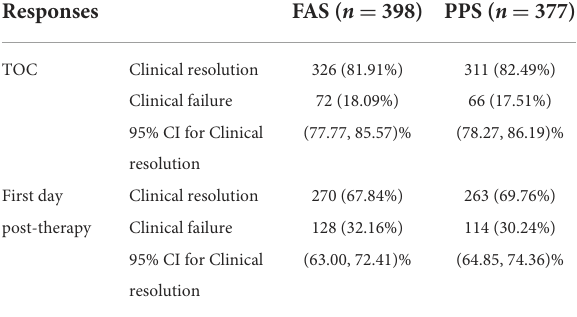
TABLE 3 Clinical responses of the PPS and FAS populations at the TOC visit and the first day post-therapy visit.